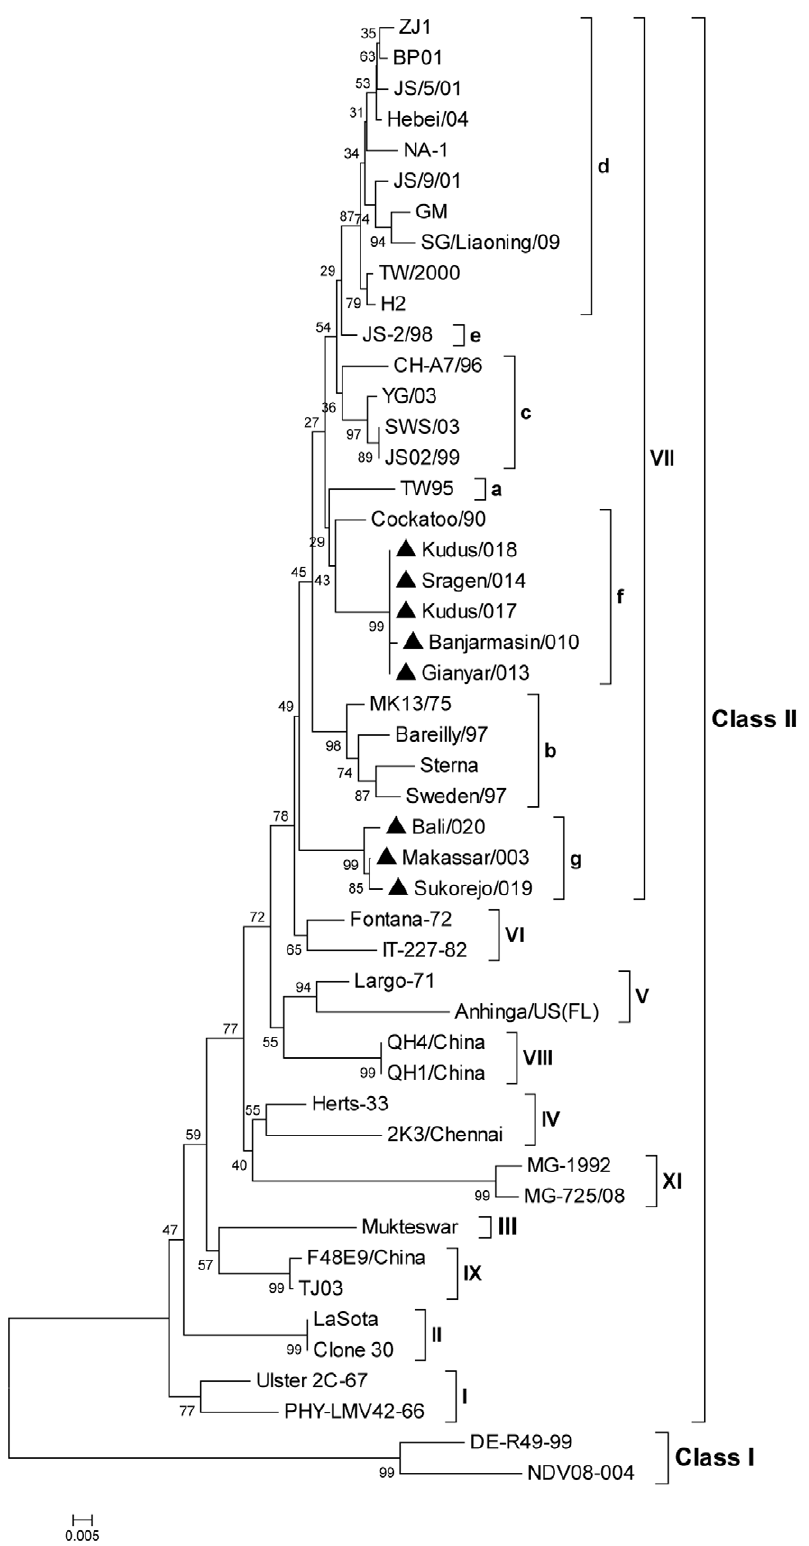
Figure 1. Phylogenetic analysis based on the nucleotide (nt) sequences of complete F open reading frame of Indonesian strains in all genotypes of NDV. The tree was constructed by bootstrap analysis (1000 replications) using the neighbor-joining of the Kimura-2-parameter method for nt differences in the MEGA 4.0 phylogenetic analysis program. Scale bar shows number of base substitutions per site. Bootstrap values are shown at the nodes.